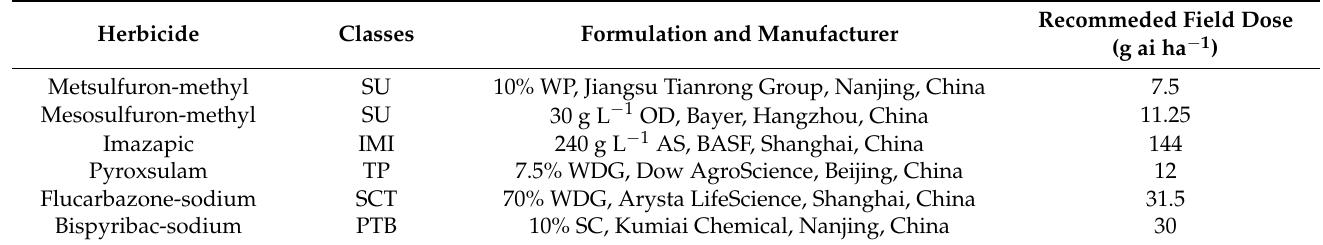
Table 3. Detailed information of ALS herbicides used in this